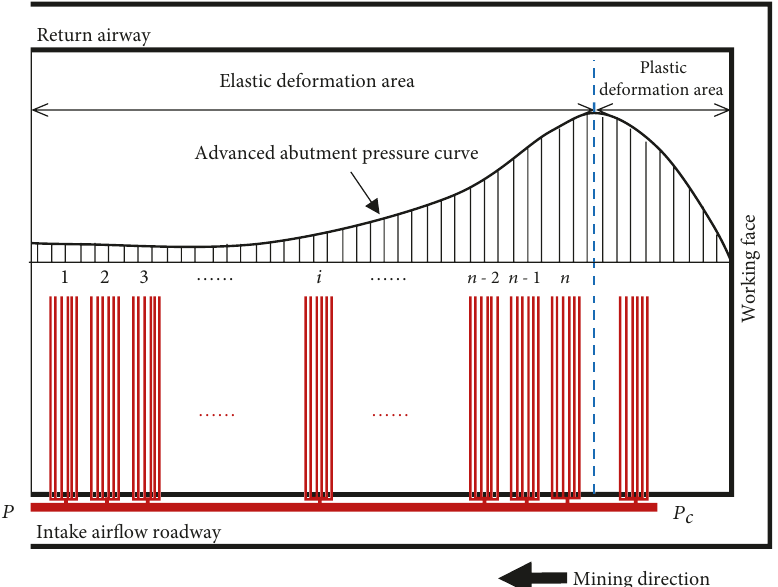
Figure 2: Schematic diagram of gas drainage characteristic zoning and distribution of drainage boreholes at the mining seam.